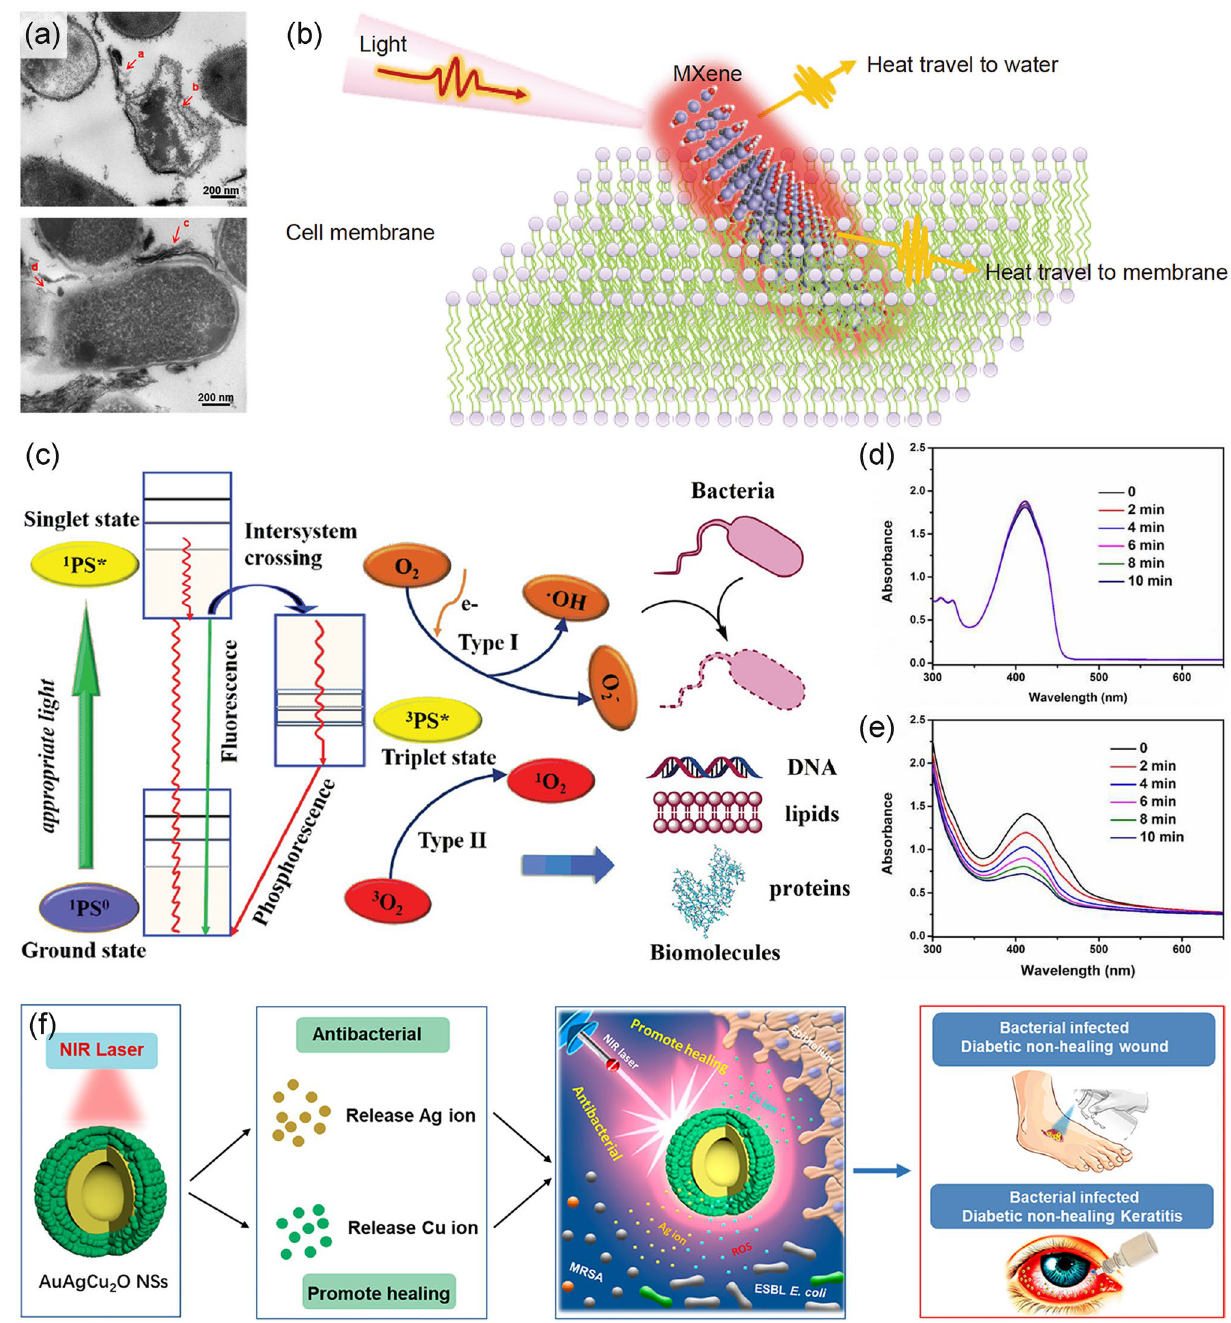
Fig. 7 a TEM images of diverse bacteria treated with 200 μg mL −1 of Ti 3 C 2 T x for 4 h [121]. Copyright 2016, American Chemical Society. b Schematic illustration of antibacterial mechanisms of MXenes with photothermal effect [37]. Copyright 2021, Springer Nature. c Photodynamic therapy mechanism of PSs under light irradiation [135]. Copyright 2019 Wiley–VCH. d Detection of DPBF’s singlet oxygen generation upon 808 nm NIR light irradiation; e Detection of singlet oxygen generation over Ti 3 C 2 T x upon 808 nm NIR light irradiation [38]. Copyright 2017, American Chemical Society. f NIR-activated Ag ions and Cu ions kill bacteria and improve wound healing [108]. Copyright 2020, American Chemical